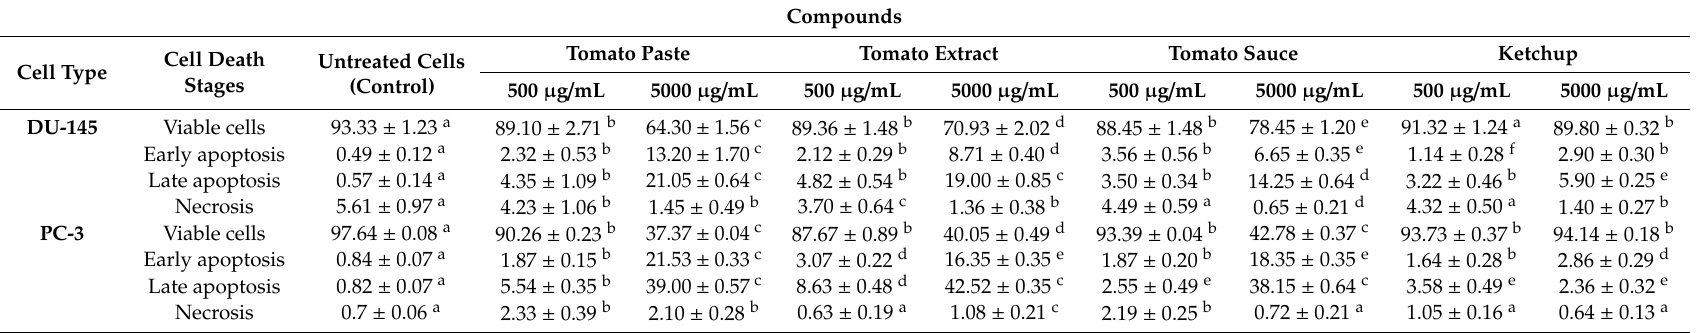
Table 2. E ff ect of tomato-based products on di ff erent cell death stages in human prostate cancer cell lines (DU-145 and PC-3) after 96 h.